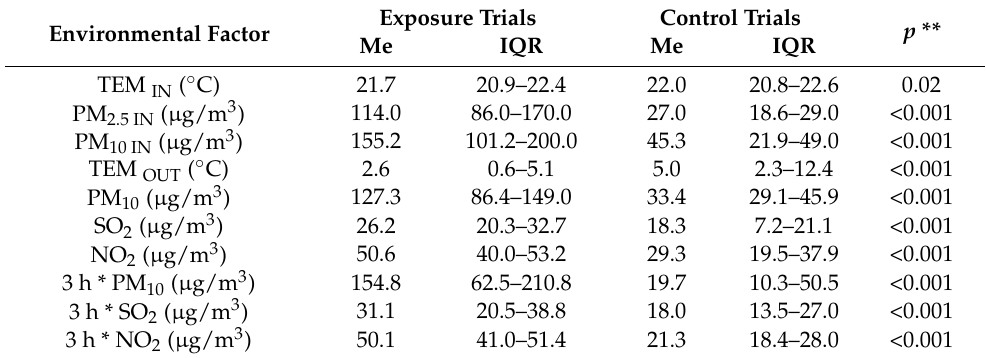
Table 2. Distribution of environmental conditions recorded during and before the training ( n =